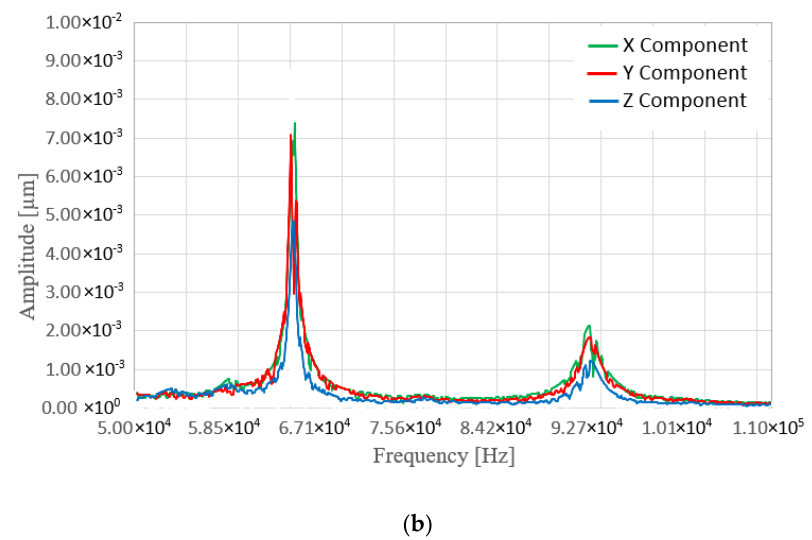
Figure 13. Measured vibrations of the actuator with triangle-shaped flange: ( a ) deformations of the actuator with disc-shaped flange at 93.72 kHz; ( b ) amplitude vs. frequency graph, peaks of oscillations at 64.8 and 93.72 kHz. Red-X, green-Y, blue-Z coordinates.